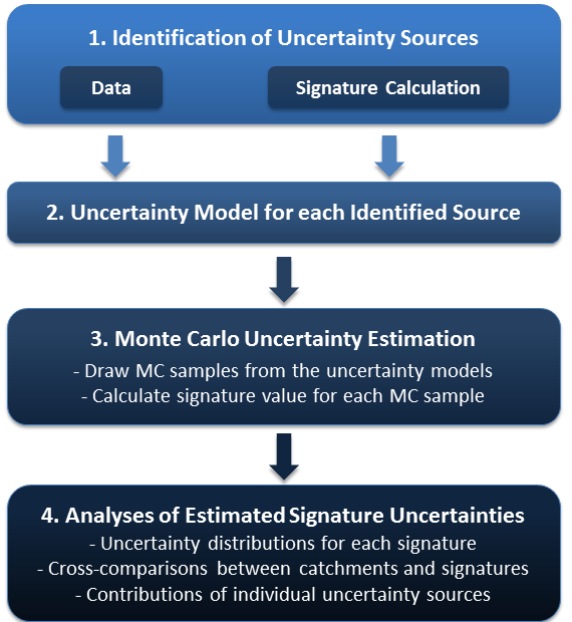
Figure 3. Schematic description of the method used for estimation of signature